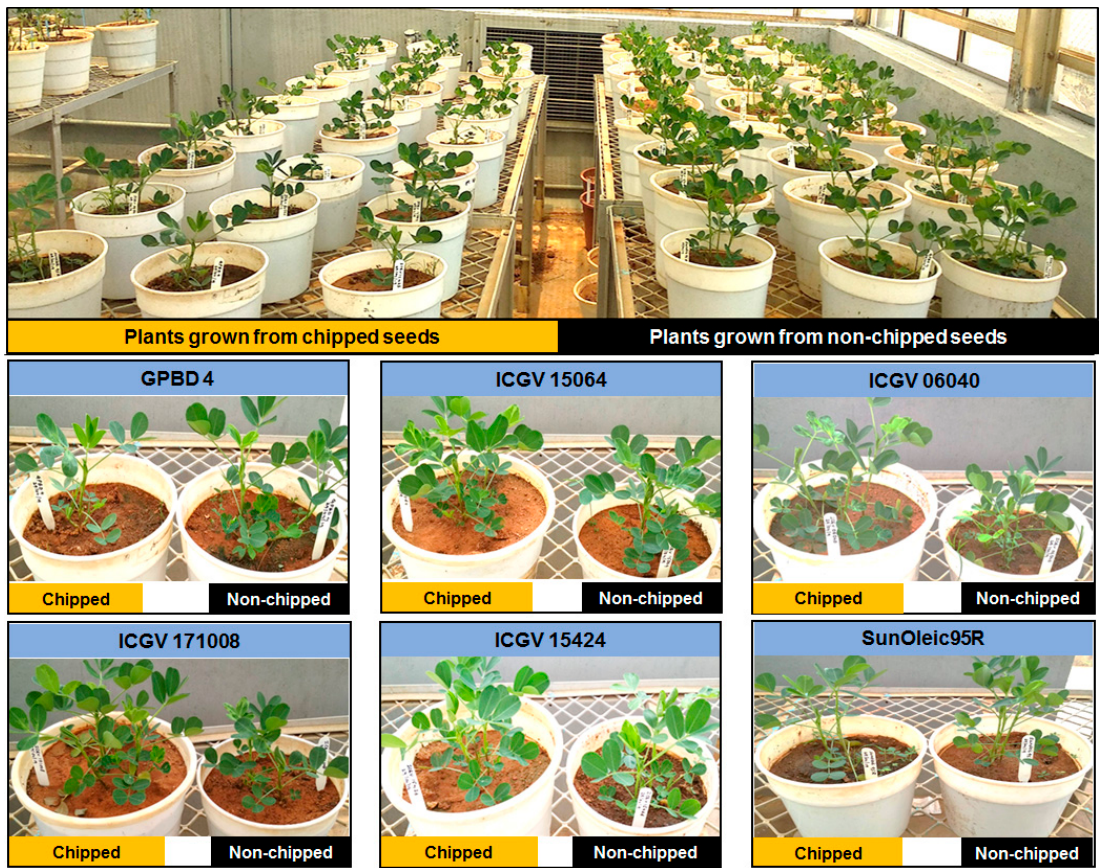
Figure 2. Comparative germination rate assessment for chipped and non-chipped